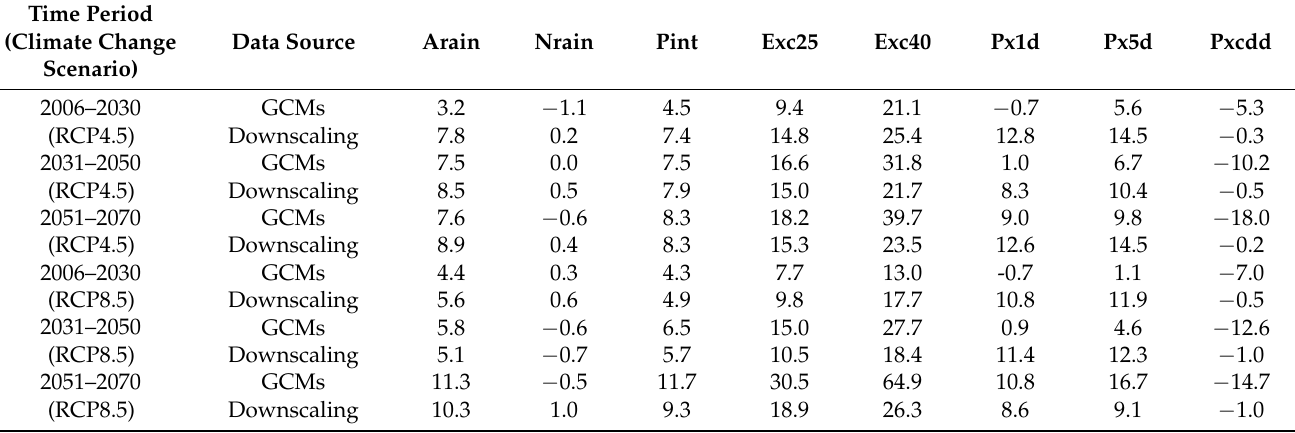
Table 2. Comparison of regional average percentage changes in the eight precipitation indices in the Beijing-Tianjin-Hebei region during the future three periods calculated from the raw GCM outputs and downscaling data by WG (unit: %).